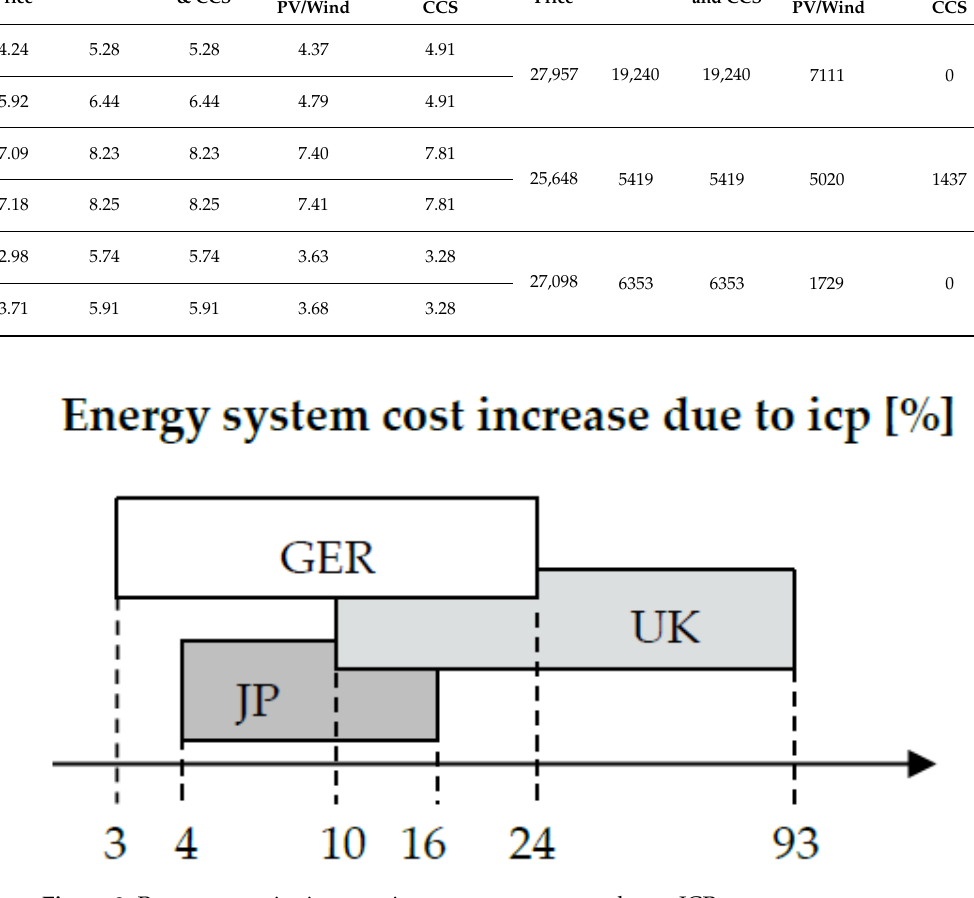
Figure 9. Percentage price increase in energy system cost due to ICP